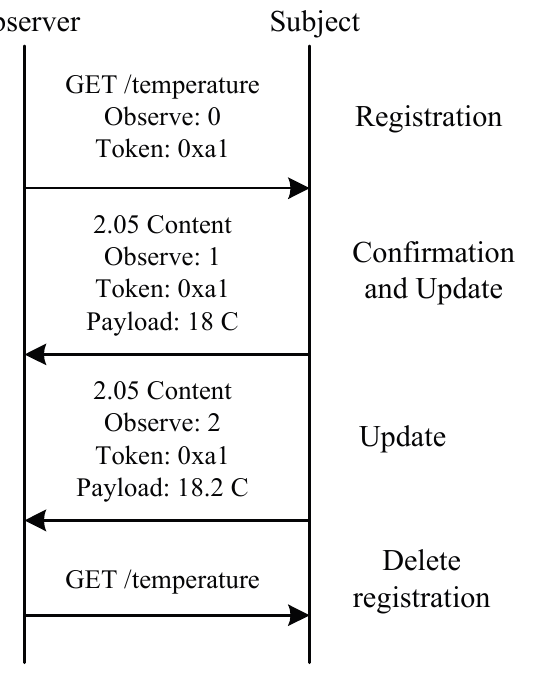
Figure 4. Observe protocol. The observer deletes its registration after receiving two